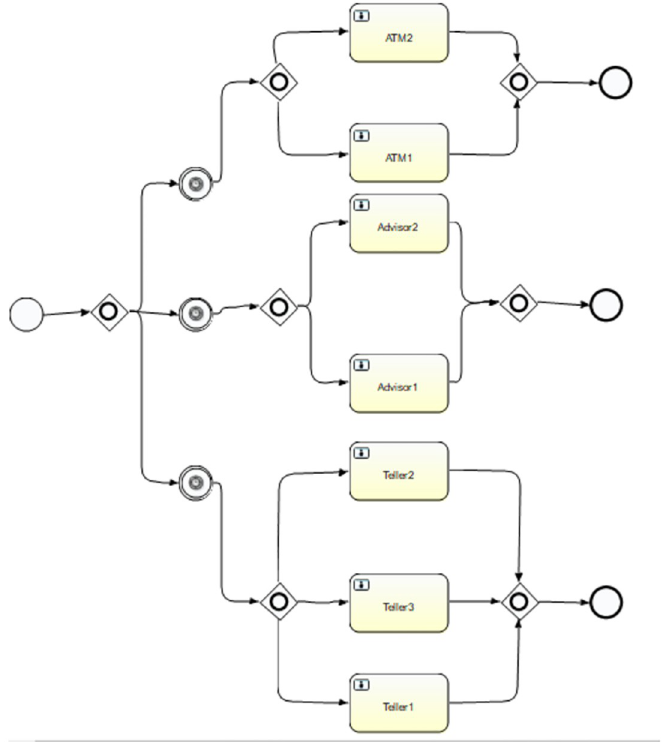
Fig 8. After reading models the BPMN generated as above, for both Simul8 and BPsimulator same BPMN model is generated.